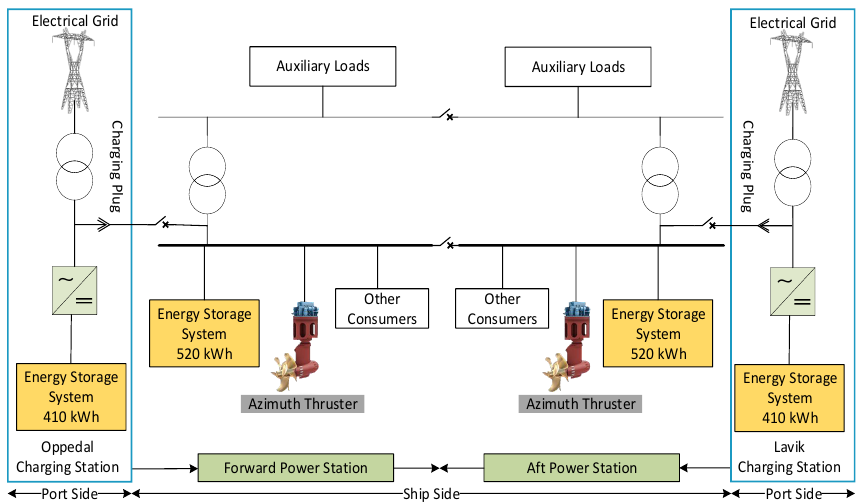
Figure 19. Schematic diagram of MF Ampere